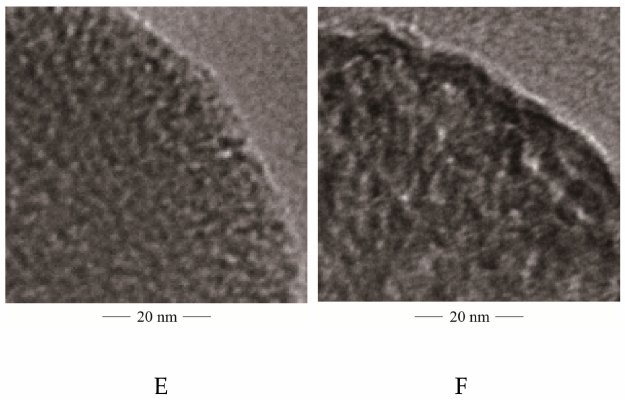
Figure 3. ( A ), SEM images of CMSN; ( B ), SEM images of E-CMSN; ( C ), TEM images of CMSN; ( D ), TEM images of E-CMSN; ( E ), Enlarged TEM images of CMSN; ( F ), Enlarged TEM images of E-CMSN.